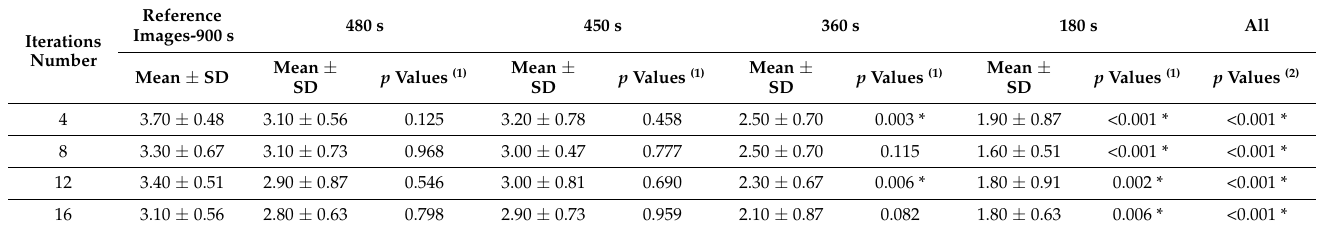
Table 5. Diagnostic confidence scores by 4-point Likert scale across 2 readers for different acquisition